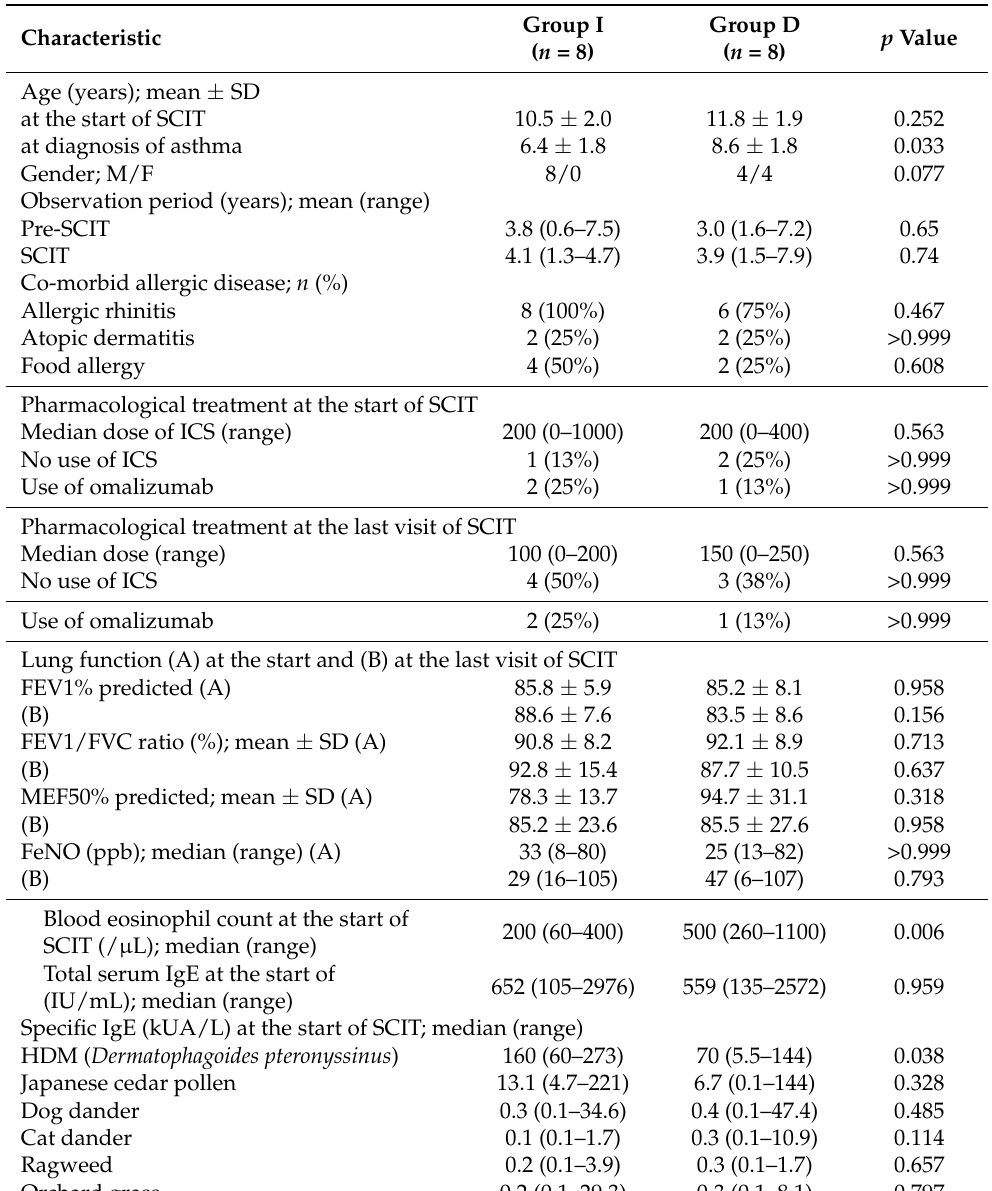
Table 3. Comparison of clinical characteristics between the two